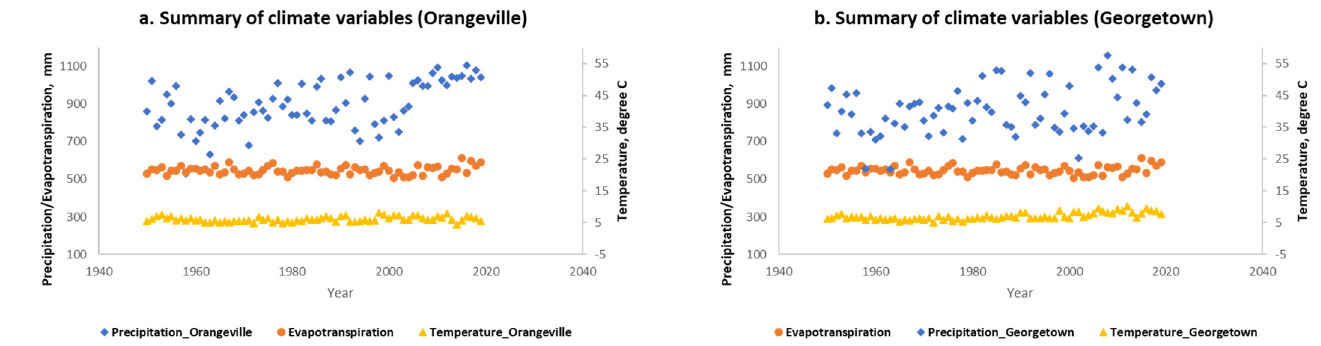
Figure 2. Annual mean temperature, total annual precipitation, and evapotranspiration (1950–2019) of the rural ( a ) Orangeville and urban ( b ) Georgetown sites.